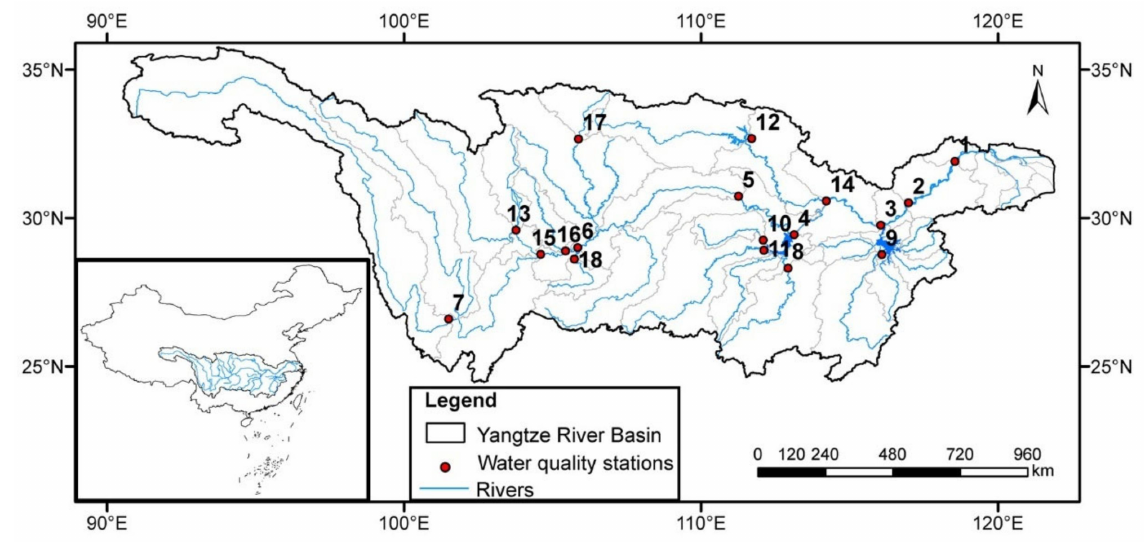
Figure 1. The location of water quality stations in the study